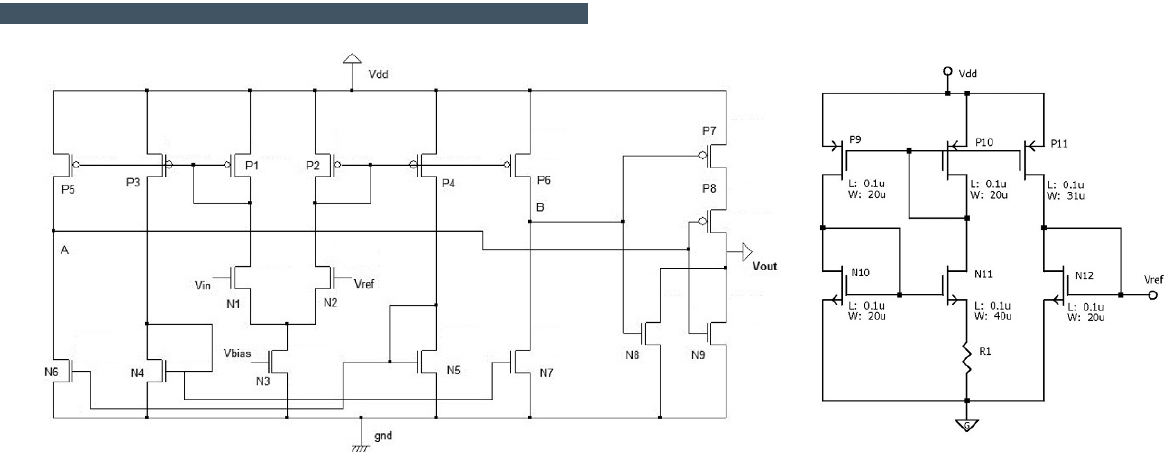
Figure 2. Detection circuits for the proposed TR-UWB